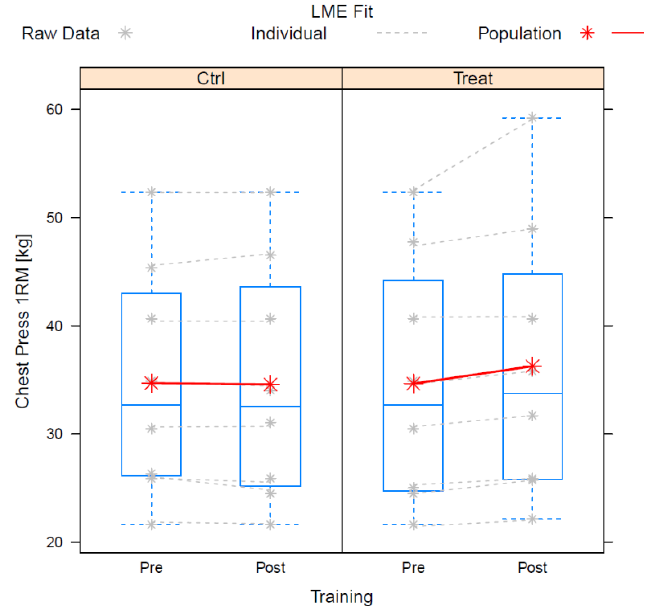
Figure 3. Boxplots of the raw data of the individual fits and of the population fits for chest press.